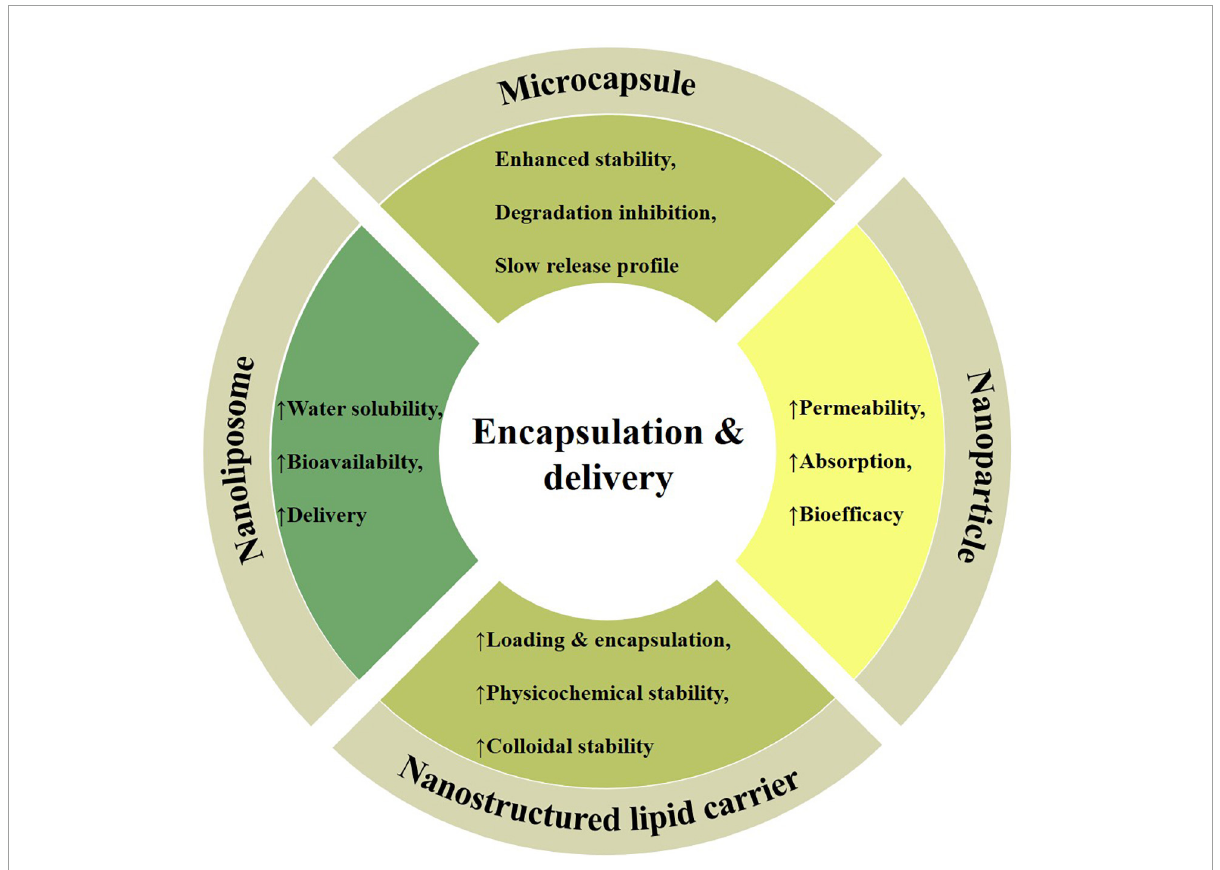
FIGURE4 Different encapsulation and delivery strategies, including; microcapsules (enhanced stability and controlled release), nanoparticles (higher absorption and bioactivity), nanostructured lipid carriers (improved physicochemical stability), and nanoliposomes (higher solubility and bioavailability) with their unique properties being employed as efficient carriers of cardamom